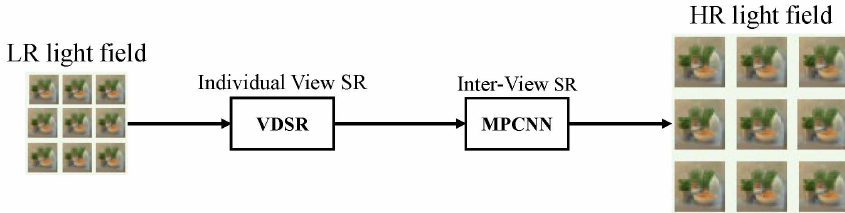
Figure 9. Network structure proposed by Fan